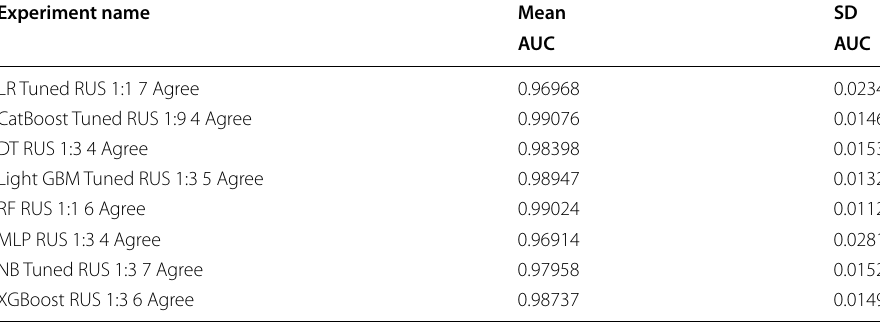
Table 20 Maximum AUC by classifier for the data exfiltration attack type; mean and standard deviations of AUC, (10 iterations of 5-fold